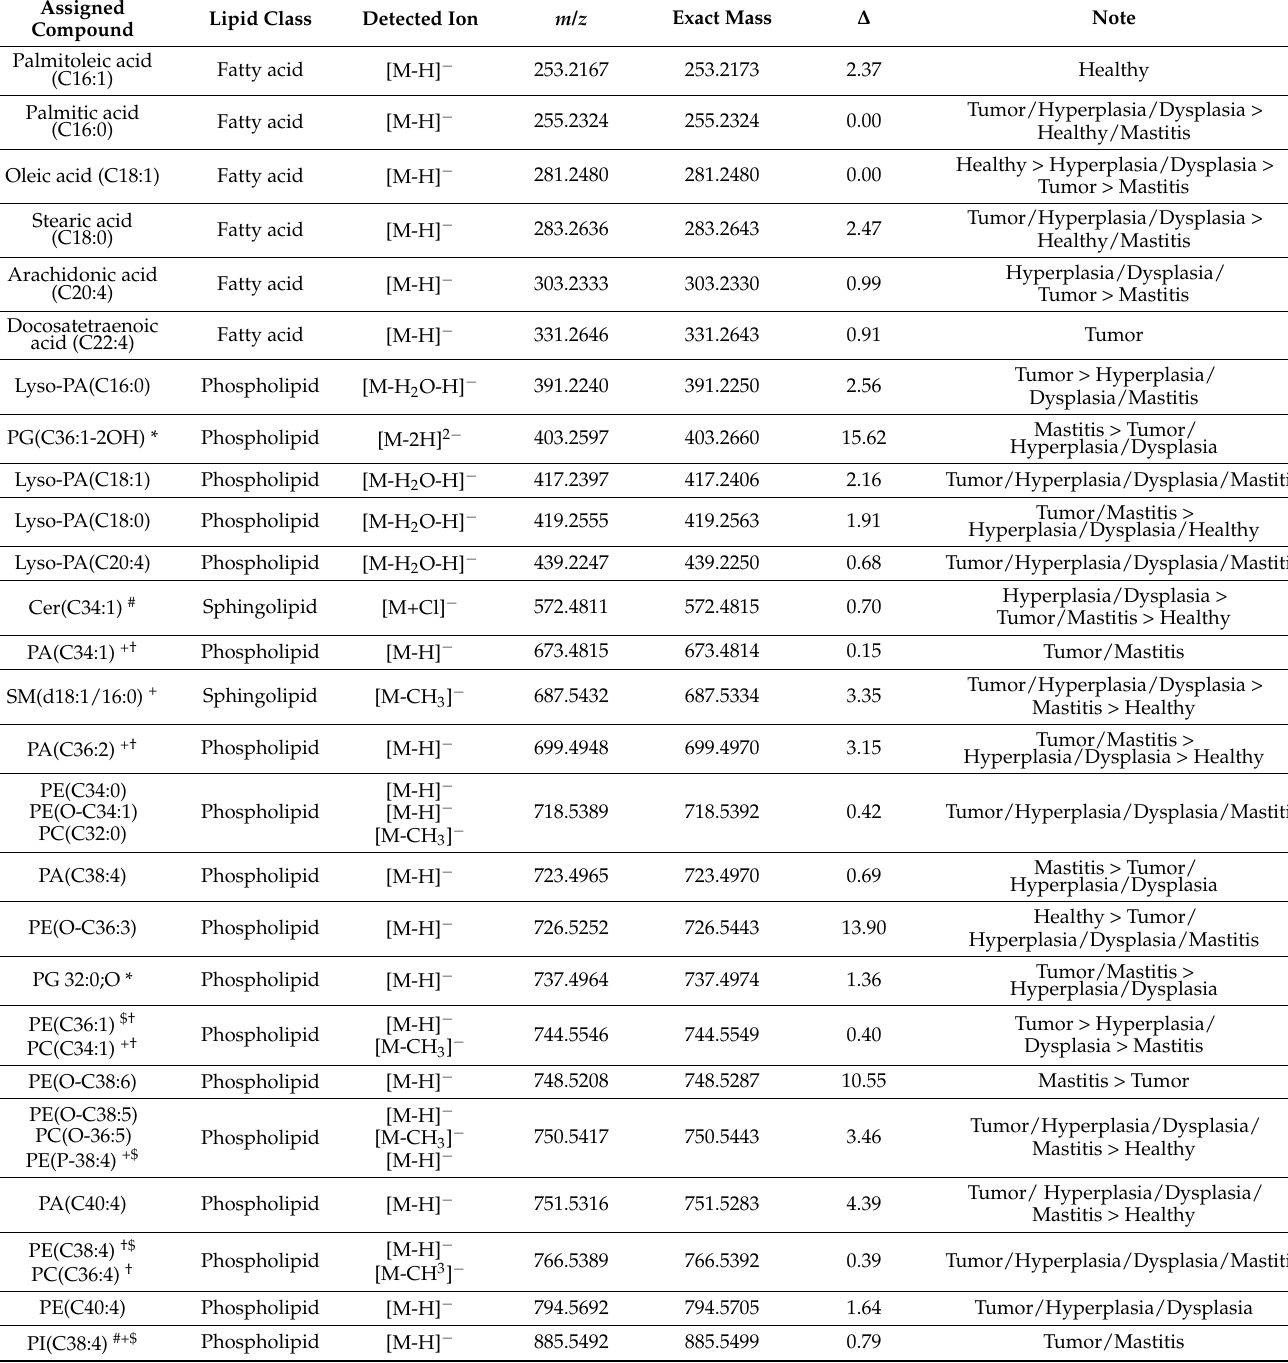
Table 1. List of discriminant features according to the PC1 loading plot, along with the calculation of the mass error ( ∆ ) resulting from the difference between the theoretical mass (Exact Mass) and the observed m / z value, and a note about the statistical class in which it was mainly detected and/or quantitative comparison. * oxidized species; # confirmed by the literature [31]; + confirmed by the literature [24]; † confirmed by the literature [26,28]; $ confirmed by the literature [32]. The assigned compounds indicated with symbols (#,+,†,$) were already reported in previous studies dealing with cancer in both animal and human